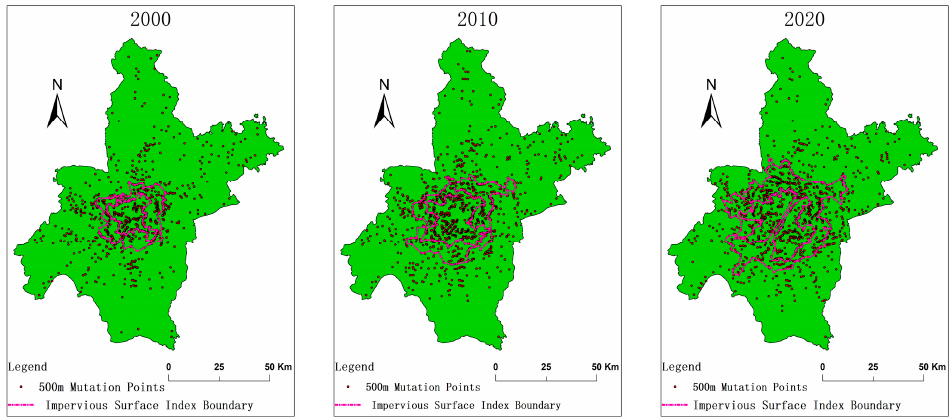
Figure 5. Impervious surface ratio of Wuhan City 2000–2020 extracted urban fringe area range.